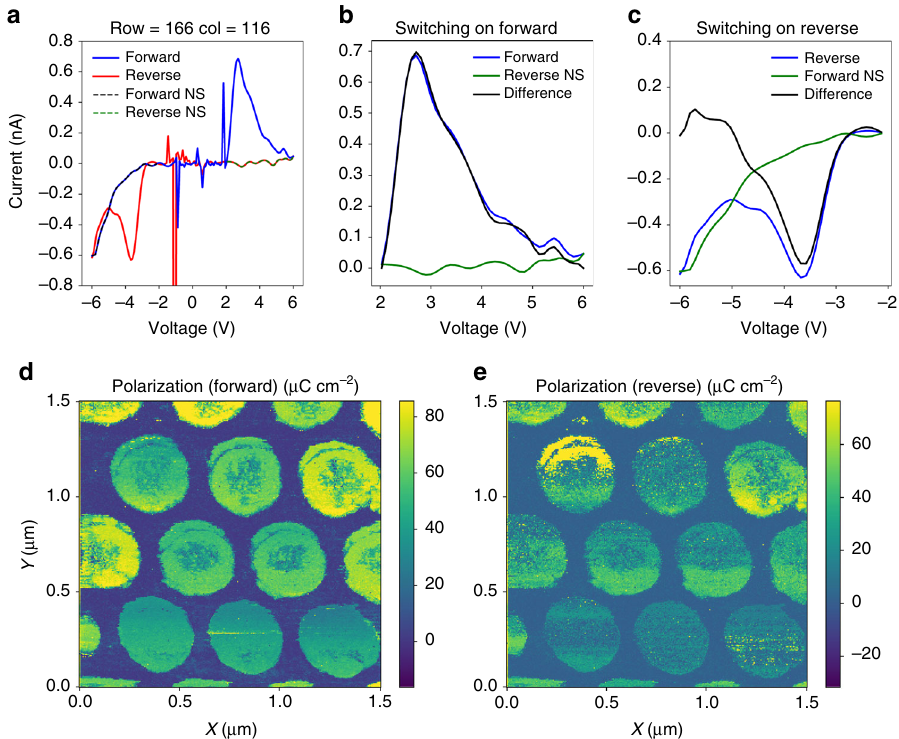
Fig. 6 Quantitative mapping of polarization. a Example of a I – V curve measured on a capacitor (the capacitance contribution has been subtracted). The forward and reverse traces are plotted in blue and red. The non-switching components of the current are plotted as dashed black and green lines, respectively. Subtraction of the non-switching current from the total current allows the switching current traces to be extracted, as shown in b , c for the forward and reverse sweep directions, respectively. Numerical integration (after conversion from voltage to time, given measurement frequency) allows extraction of the polarization maps, as seen in d , e . This con fi rms the quantitative nature and utility of the G-IV